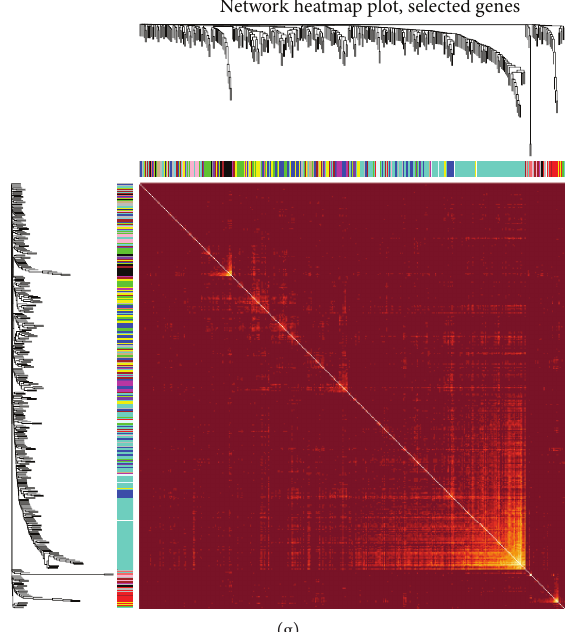
Figure 2: WGCNA analysis of combined datasets. (a) Scale independence and mean network connectivity for soft thresholding powers ( β ). β � 6 was selected to achieve model fit maximization. (b) In total, 22,848 genes were assigned to 19 modules, including one gray module, with cutoff of powers � 6. The top image shows a gene dendrogram, and the bottom image shows the gene modules with different colors. (c) Correlation between modules and traits. The upper number in each cell refers to the correlation coefficient of the corresponding module with clinical trait, and the lower number is the corresponding P value. (d) The eigengene dendrogram and heat map. The 19 modules are relatively independent, and the brown module was strongly correlated with APA. (e), (f) Scatter plots of GS versus MM for APA in the brown and tan modules. (g) Topological overlap matrix heatmap of 400 genes selected from a total of 22,848 genes. Light color represents high overlap of the genes, and progressively darker color indicates lower overlap. Blocks of light colors along the diagonal represent the coexpression